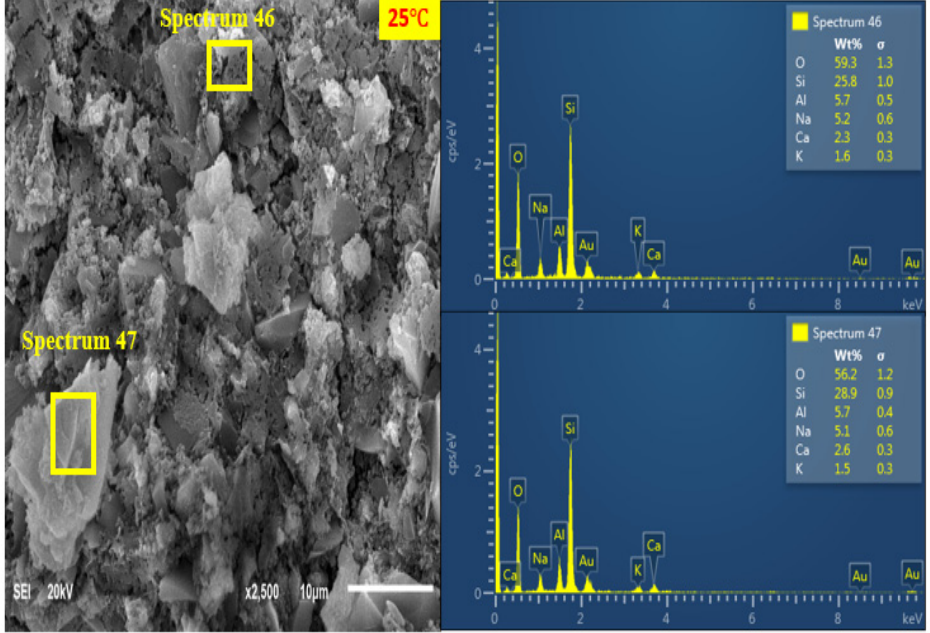
Figure 14. SEM + EDX result of AANL cured at 25 ◦ C.